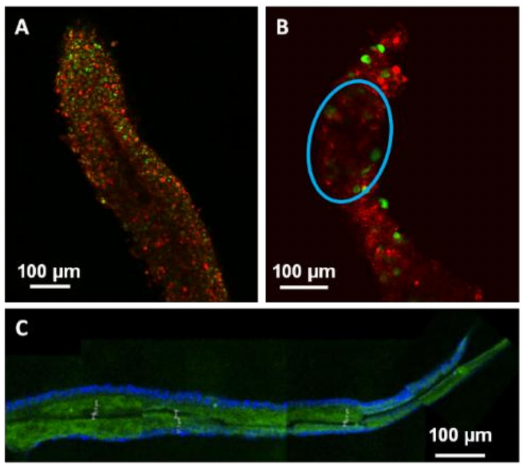
Figure 6. Confocal microscope images showing laser-induced modifications in three different types of microfibres. ( A ) Sharp channel inside a dehydrated microfibre after spending 41 min on a sample holder. ( B ) Attenuation (blue circle) of signal density inside a hydrated microfibre after 9 min spent on a sample holder. After being marked with Live/Dead ® ki, A and B colors were modified to highlight laser interaction effects. ( C ) Sharp channel inside a PFA-fixed microfibre, green: collagen- Fluorescein-5-isothiocyanate (FITC), blue: DAPI